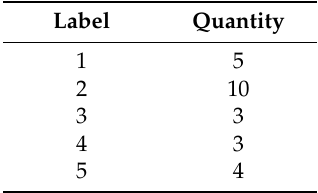
Table 7. The states arrangement of the testing sample.